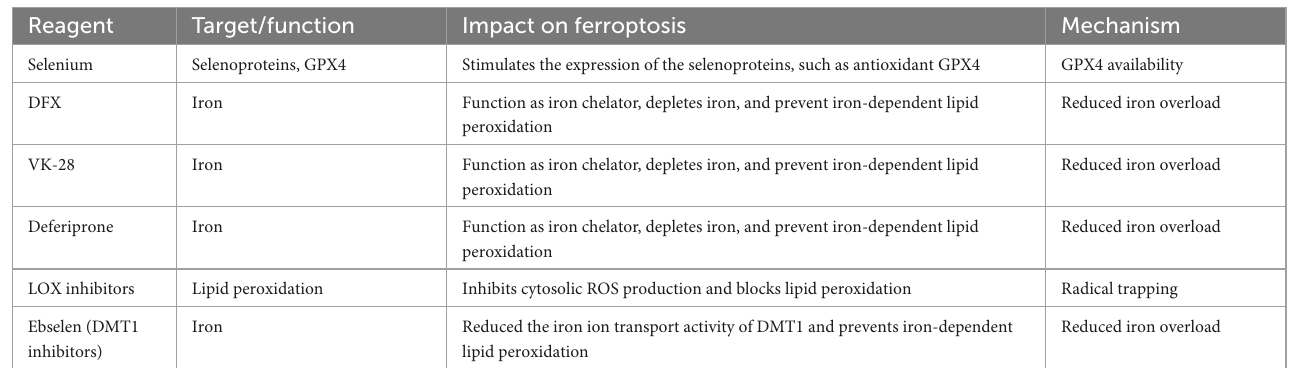
TABLE 2 Reagent associated with